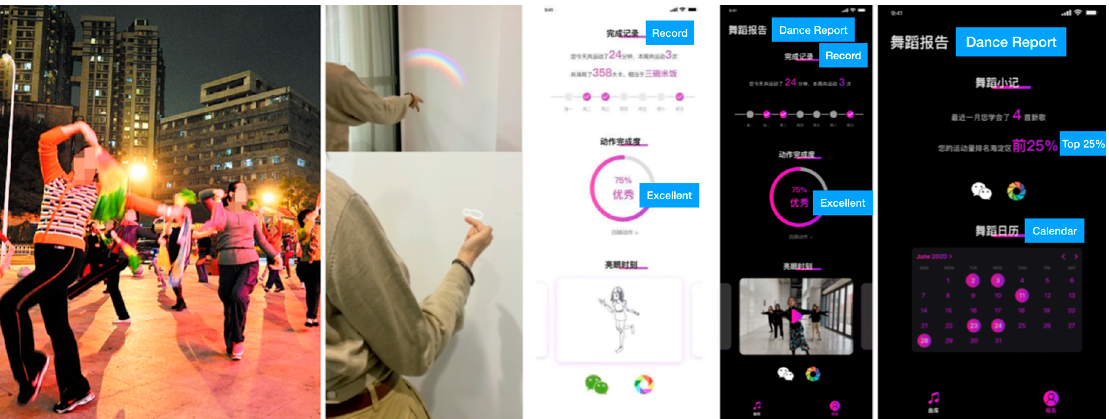
Figure 7. The gesture interactions and user interface prototypes of the mobile app.